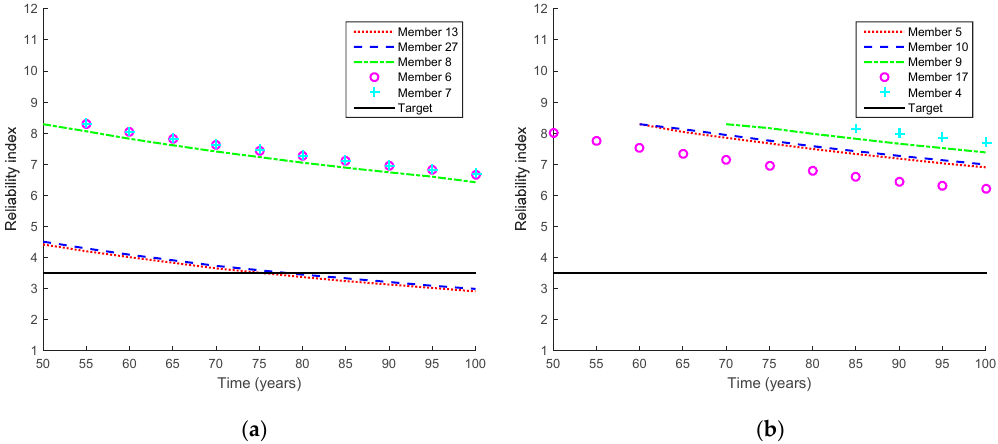
Figure 5. Reliability indices of 10 selected members obtained from proposed method. ( a ) Members